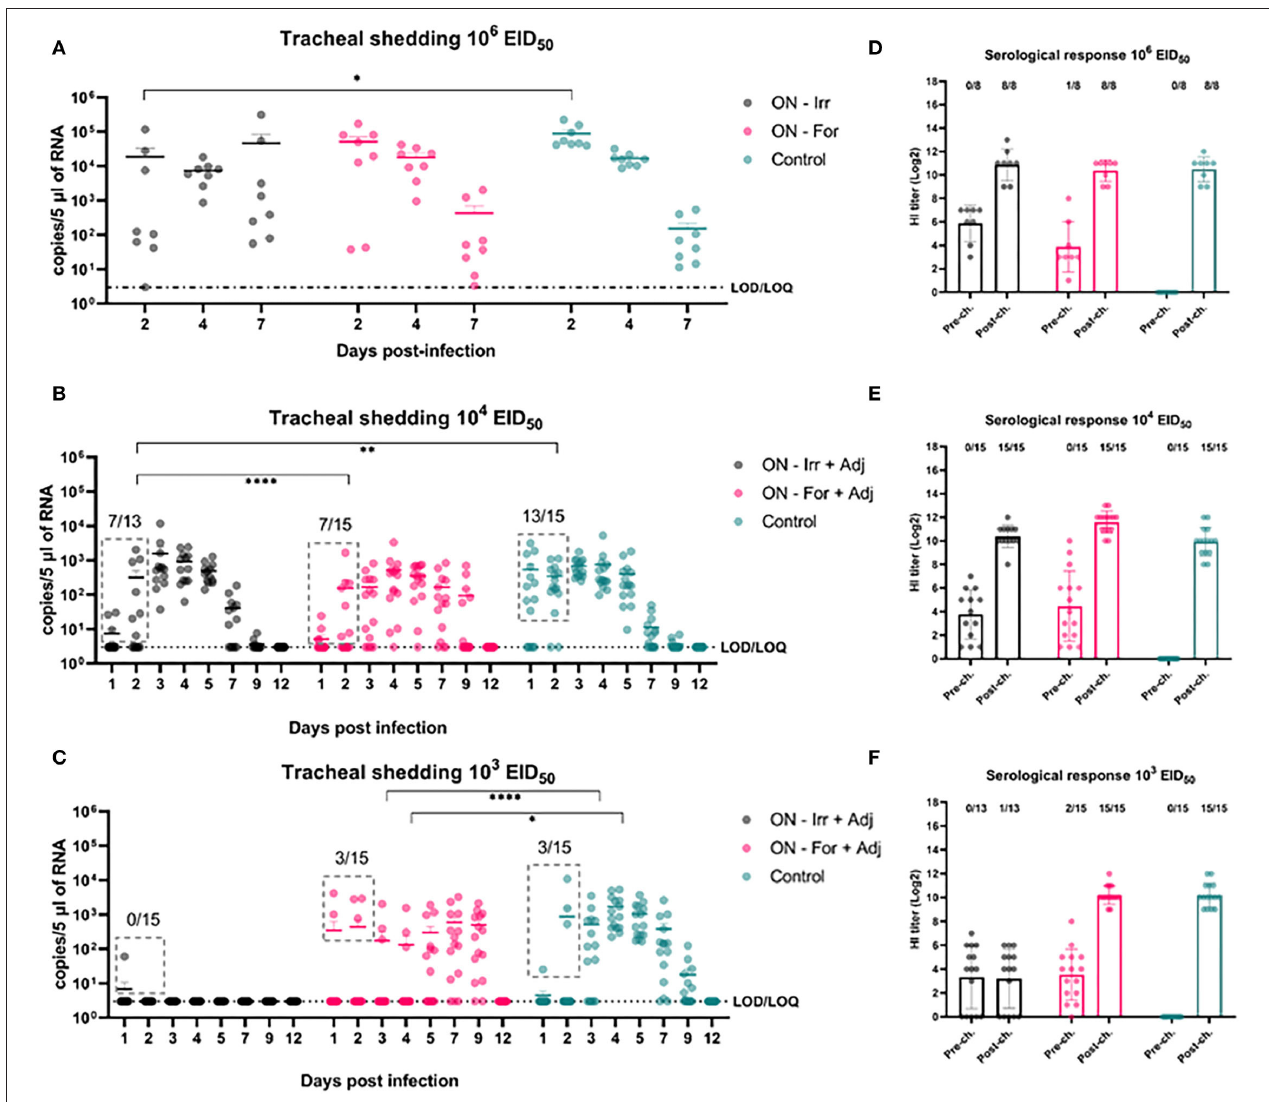
FIGURE 4 | Effects of mucosal (oculo-nasal, ON) vaccination upon infection at different H9N2 challenge doses. (A–C) qRRT-PCR results of tracheal swabs collected from all the challenged birds. (D–F) Serological test results before and after challenge. The numbers above bars indicates the number of NP-ELISA positive birds out of tested